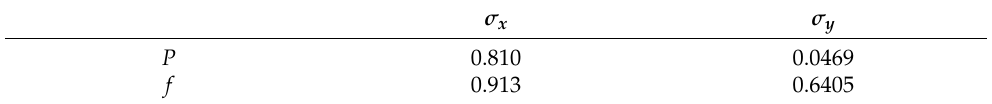
Table 5. The p -value for ANOVA test— σ x and σ y .